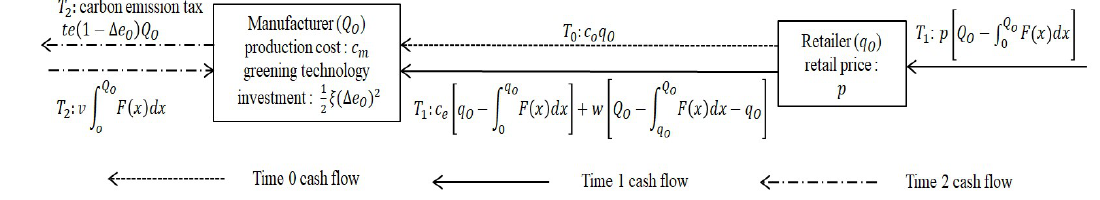
Figure 6. The cash flow of supply chain with the option contract.